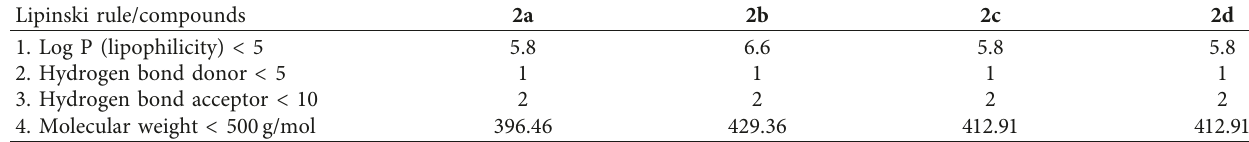
Table 2: Evaluation of Lipinski’s rule of five for compounds 2a , 2b , 2c , and 2d . Lipinski rule/compounds